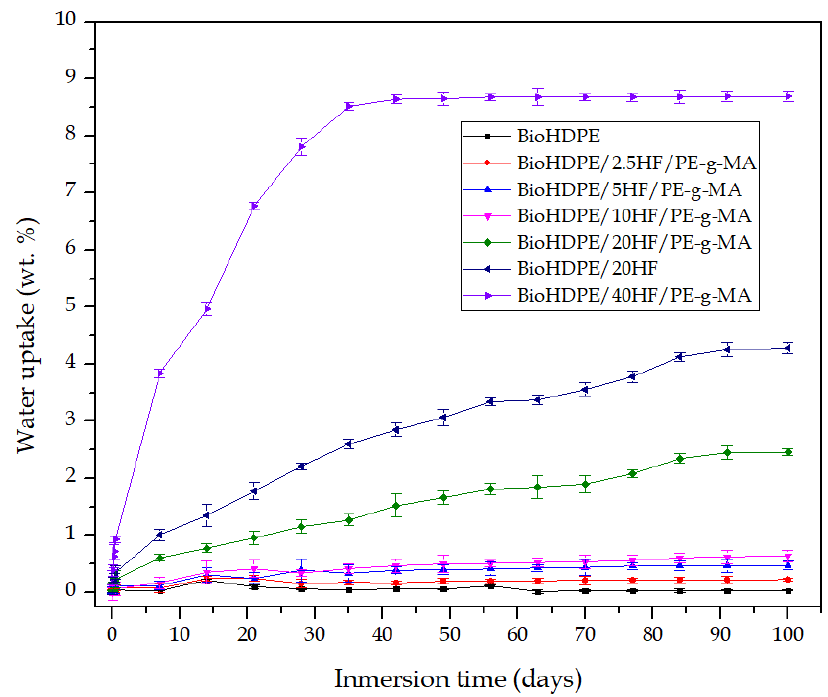
Figure 9. Water uptake of BioHDPE/Hemp fiber composites.